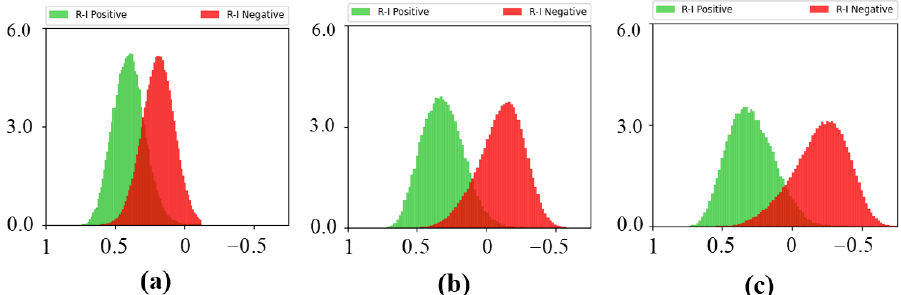
Figure 7. The distributions of the cosine similarity scores of positive and negative pairs of ( a ) B , ( b ) B + LPGAT and ( c ) B + C 3 L . The x axis shows the cosine similarity scores between RGB images and IR images, and the y axis shows the frequency statistics of the cosine similarity